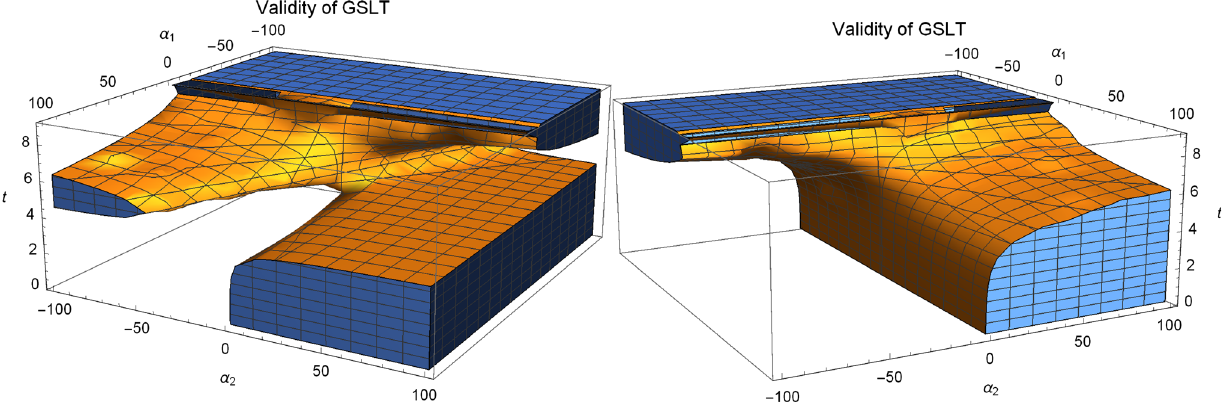
Fig. 9 Left plot represents the validity regions for logarithmic corrected entropy in power law case with δ = 2, right graph corresponds to evolution of GSLT for δ = − 2. Herein, we set λ 1 = 2 and λ 2 =